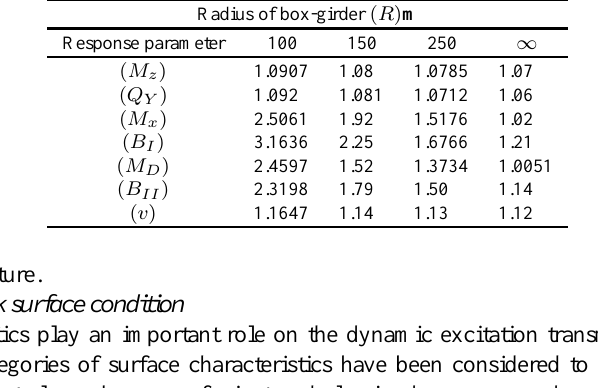
Table 8 Effect of radius of box-girder bridge on impact